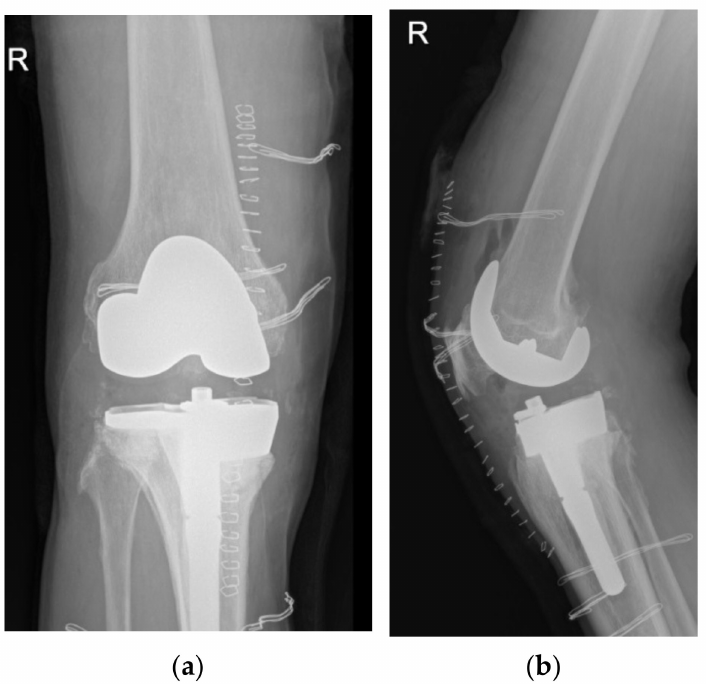
Figure 3. Anteroposterior ( a ) and lateral ( b ) postoperative right knee radiographs depicting the revision total knee construct.